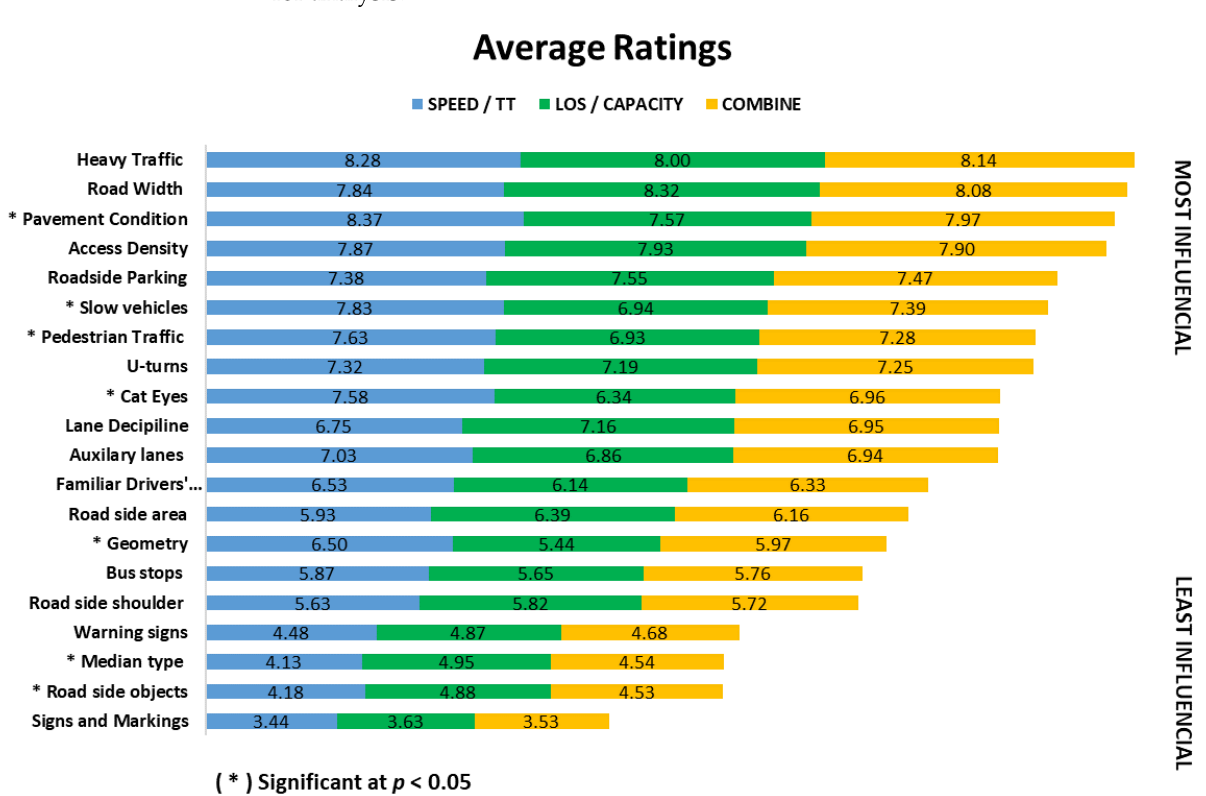
Figure 4. Ratings of Mobility Influencing Factors (Scale 1 – 10).